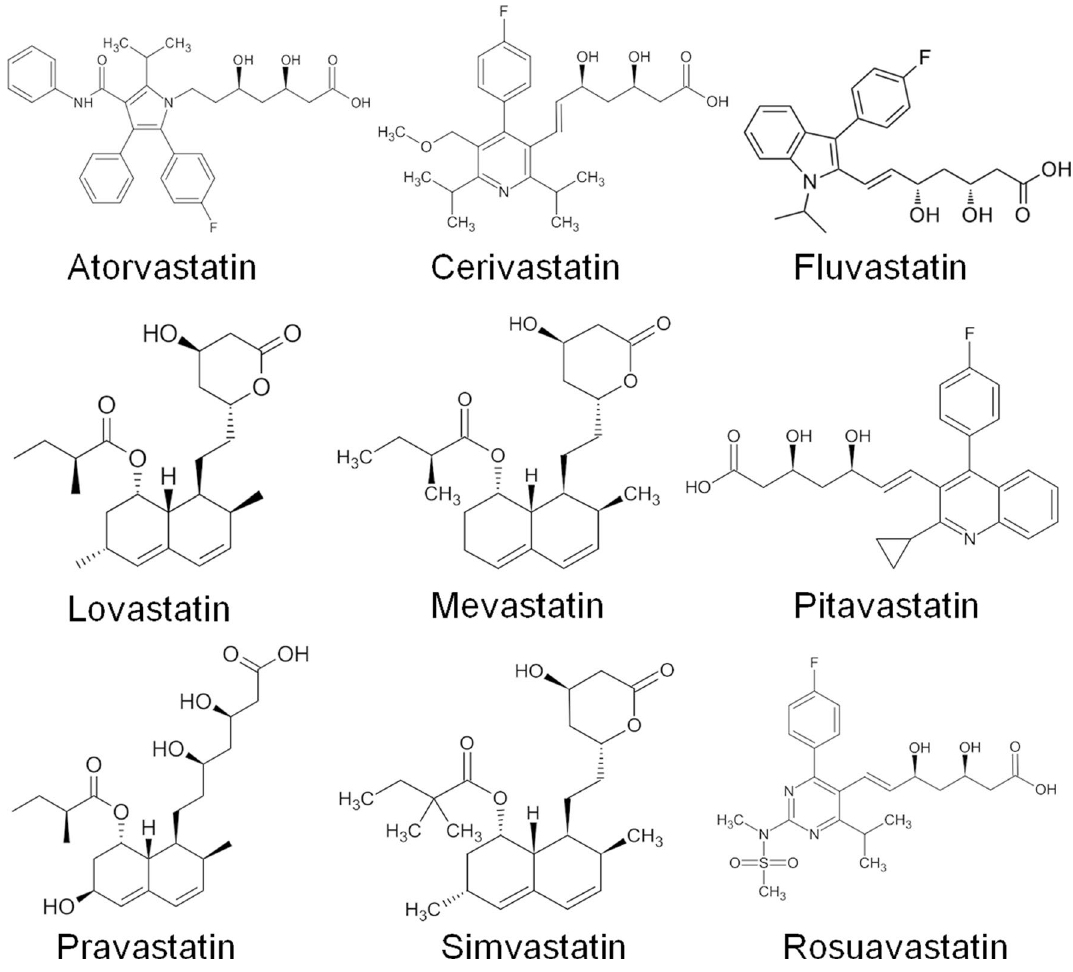
Figure 1. 2D structure of the statin